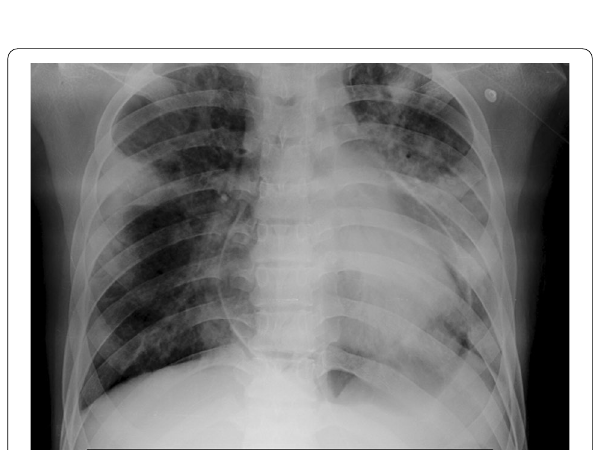
Fig. 3 X-ray chest (Antero-posterior view) on day 23 of admission shows areas of inhomogeneous opacities in central as well as peripheral locations in bilateral lung fields. The heart is seen outlined by air, consistent with significant pneumopericardium with mass effect on the underlying